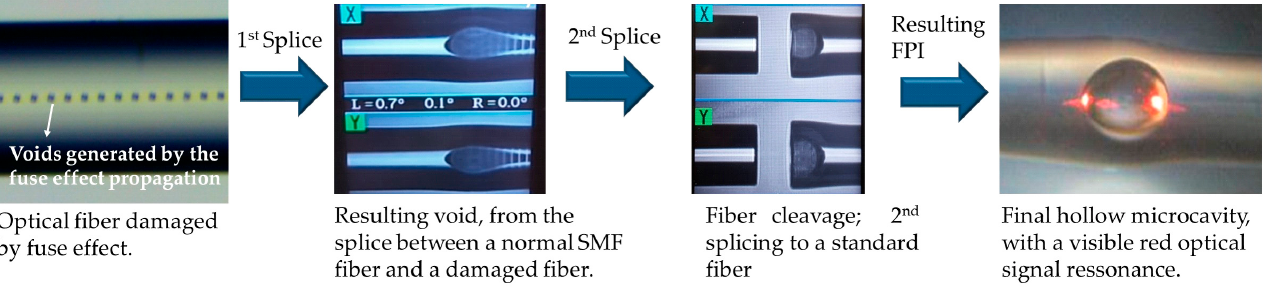
Figure 1. Hollow microcavity production by the recycling of optical fiber damaged by the catastrophic fiber fuse effect. Assembling the load cells comprised of the encapsulation of the FPIs (one for each pair of rFPI and sFPI). Two 3D printed molds with a different height ( h ) and width ( w ) were